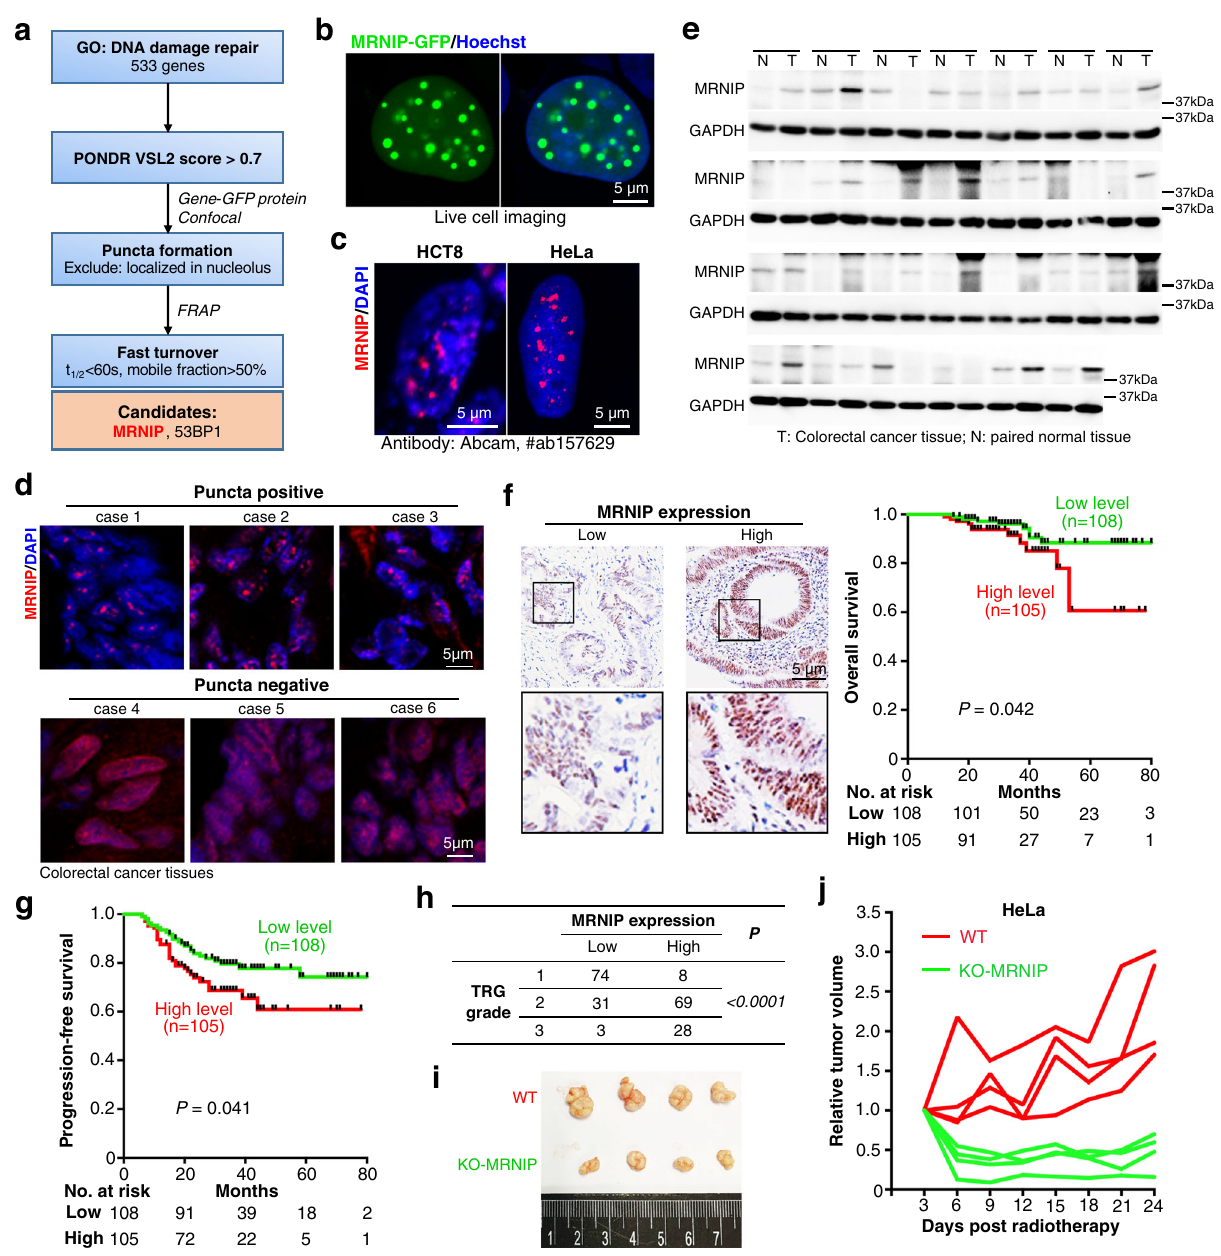
Fig. 1 MRNIP formed puncta in tumor cells and its high expression was associated with the radioresistance and poor prognosis of CRC patients. a Screening of DNA damage repair-related proteins that undergo LLPS. Details could be found in Supplementary Figure 1a. b MRNIP-GFP showed puncta in the nucleus of HEK 293T cells. HEK 293T cells were transfected with plasmid for 24h before observation. c Immuno fl uorescence of endogenous MRNIP in HCT8 and HeLa cells. d Immuno fl uorescence assay showing that MRNIP formed puncta in 3 out of 6 CRC tissues. Frozen sections of CRC tissues were analyzed using Immuno fl uorescence assay. e MRNIP protein was upregulated in CRC tissues. Twenty-seven CRC tissues and adjacent normal tissues were analyzed. f , g Higher MRNIP expression was correlated with shorter survival time of CRC patients. The correlations were analyzed with Kaplan-Meier curve and Log-rank test. h CRC patients with higher MRNIP level were more resistant to radiotherapy. TRG, Tumor regression grade. For ( f – h ), CRC tissues from 213 patients were analyzed. i , j Xenograft model showed that MRNIP depletion sensitized tumor cells to radiation. For ( j ), each line represents one